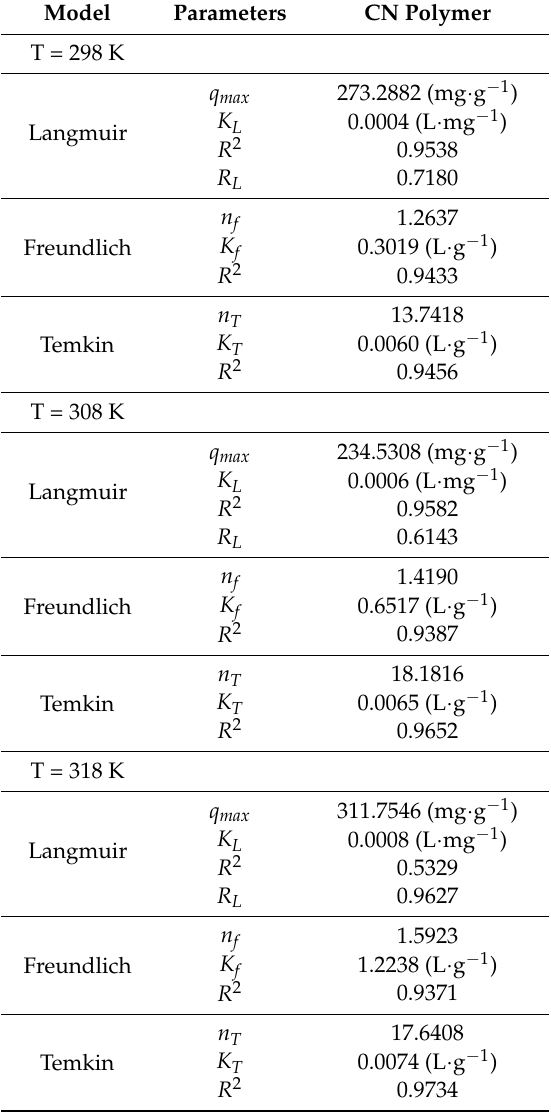
Table 3. Parameters obtained from Langmuir, Temkin and Freundlich isotherm models to AMI adsorption by CN polymer at 298 K, 308 K and 318 K, pH 7 and saturation time of 300